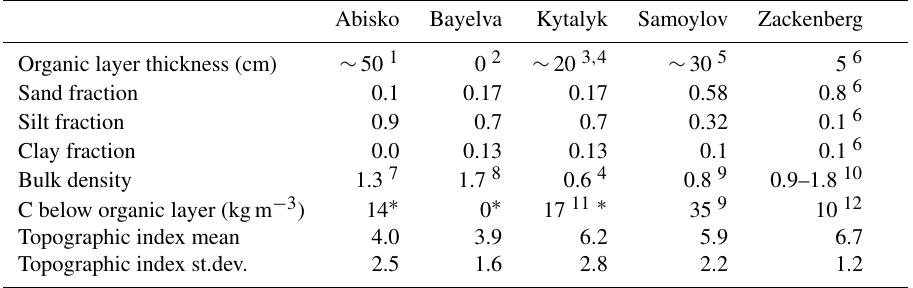
Table A1. Parameters for the sites. 1 (Klaminder et al., 2008). 2 J. Boike, personal communication, 2015. 3 (Van Huissteden et al., 2005). 4 (van der Molen et al., 2007). 5 (Boike et al., 2013). 6 (Hollesen et al., 2011). 7 (Rydén et al., 1980). 8 (Roth and Boike, 2001). 9 S. Zubrzycki, soil carbon data. 10 PAGE21 catalogue of physical parameters. 11 (Bartholomeus et al., 2012). 12 (Elberling et al., 2008). In most cases soil types (see Sect. 2.3) were translated to approximate sand–silt–clay fractions using Table 1 in (Beringer et al., 2001). Topographic index is from a global dataset: a 0.5 ◦ aggregate from US Geological Survey (2000).